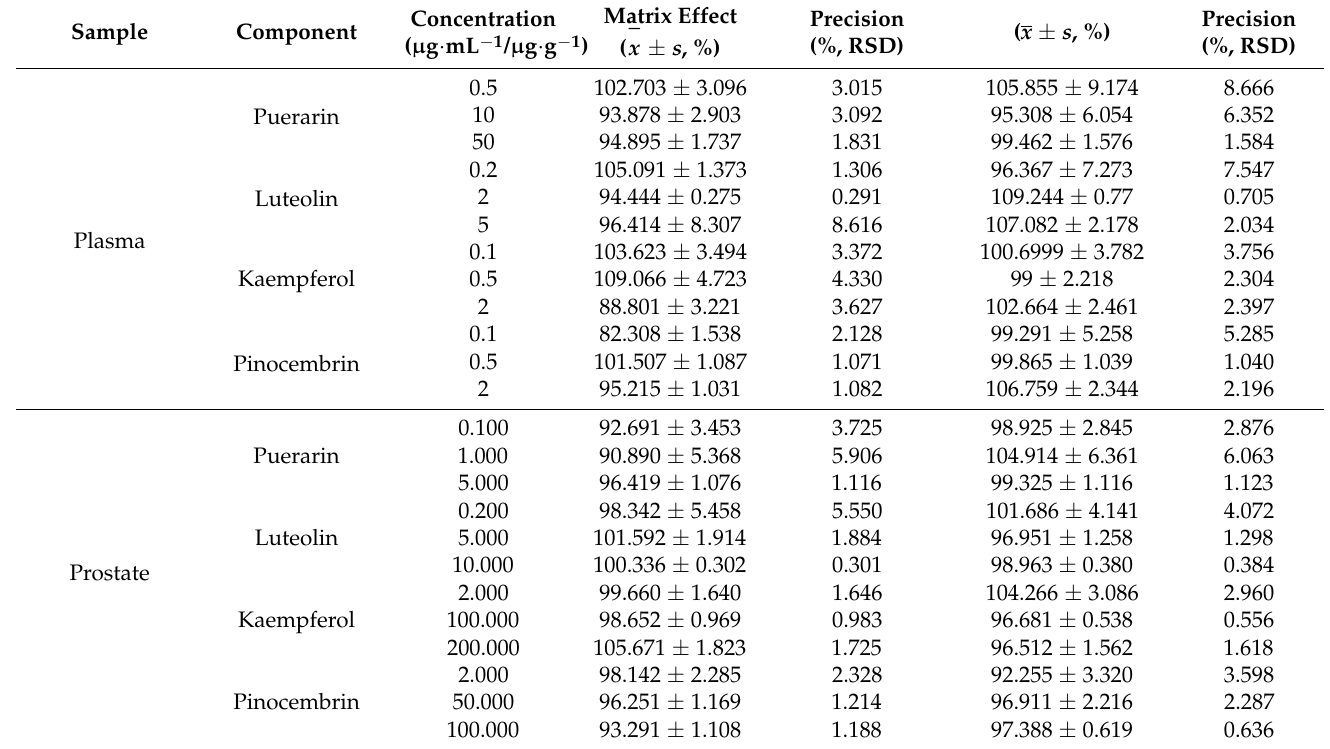
Table 4. Extraction recovery and matrix effect of four analytes in plasma and prostate ( n =